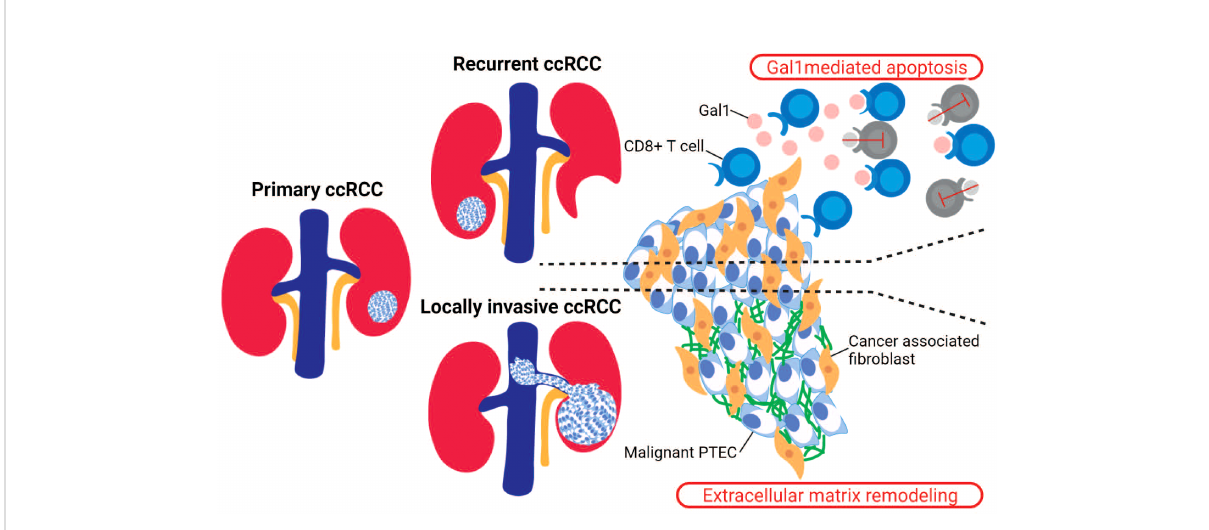
FIGURE 3 Stromal cells in recurrent and locally invasive ccRCC. Cancer-associated fi broblasts (CAF) are stromal cells that have been identi fi ed as drivers in the recurrent and locally invasive ccRCC microenvironment. In recurrent ccRCC, the in fi ltrating CAF secrete Gal1 that binds to the activated CD8 + T cells and thus mediating T cell apoptosis. In locally invasive ccRCC, the in fi ltrating CAF increase the expression of genes within the epithelial – mesenchymal transition (EMT) pathway, leading to an increased extracellular matrix remodeling within the invasive ccRCC